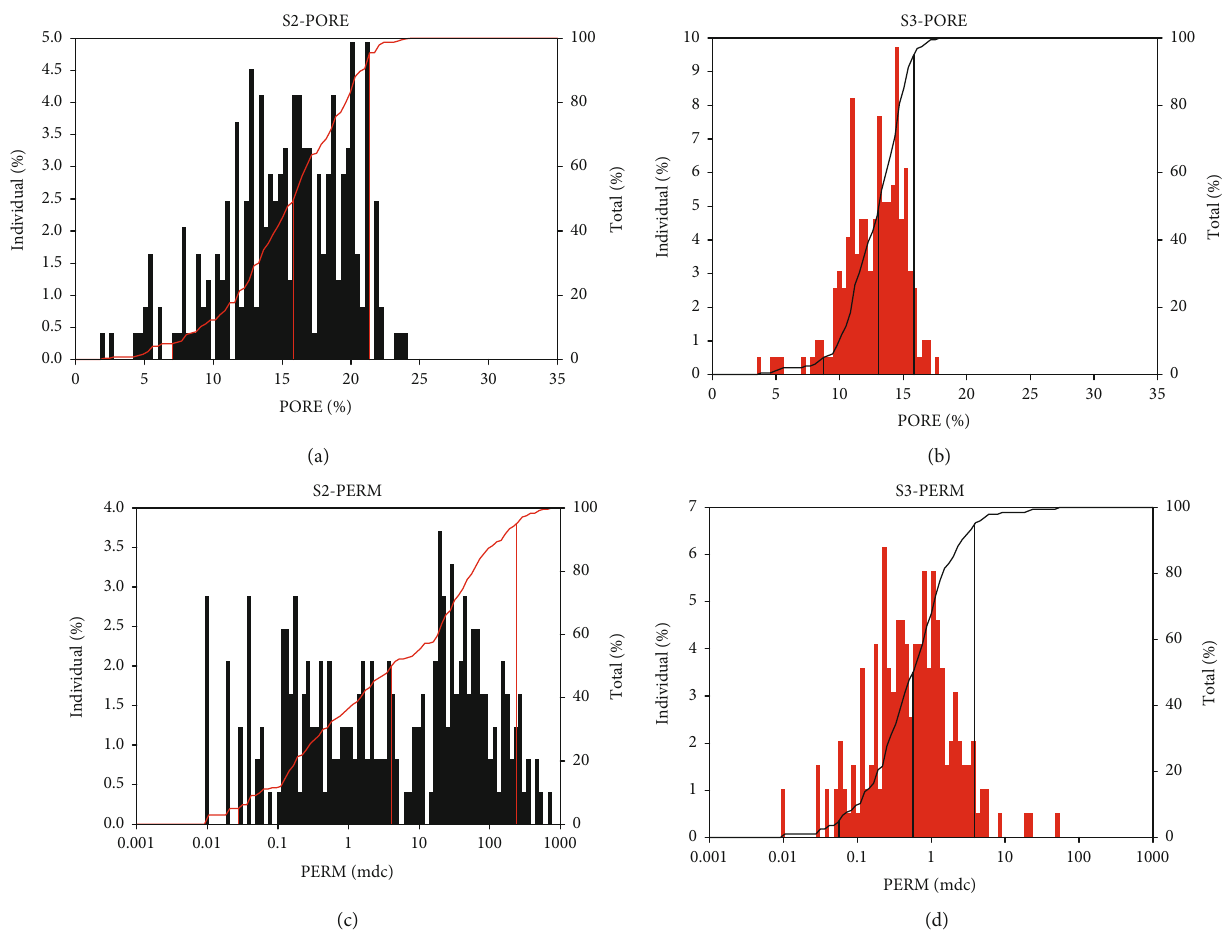
Figure 4: Frequency distribution histogram of permeability and porosity of S